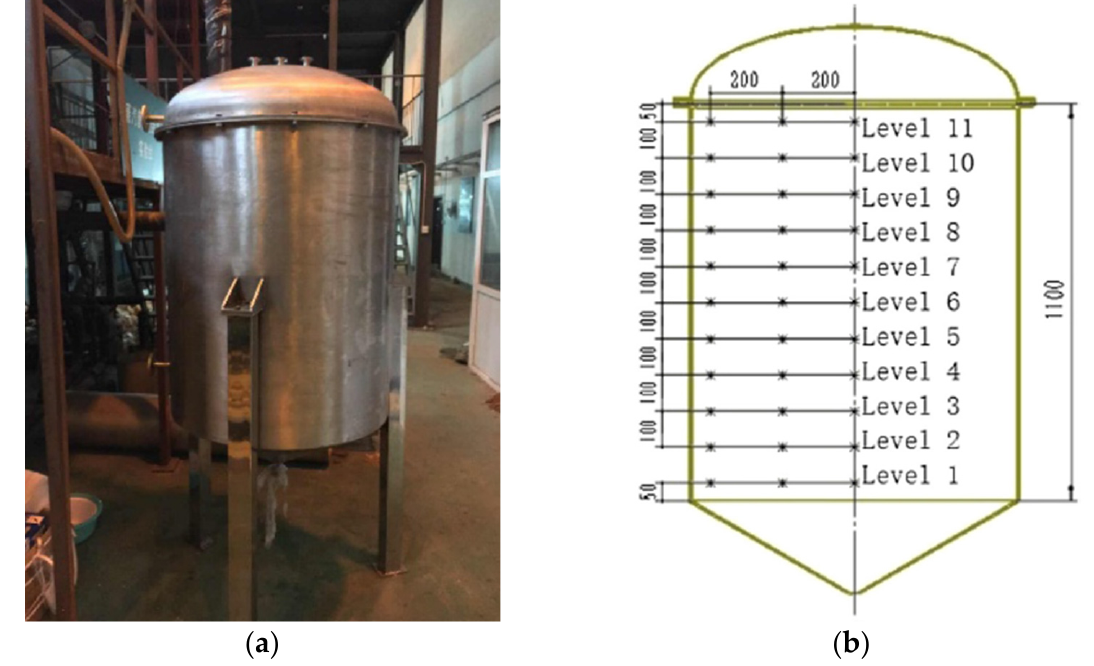
Figure 1. ( a ) A view of the examined tank; ( b ) a scheme representing a location of thermocouples (source: [29]).